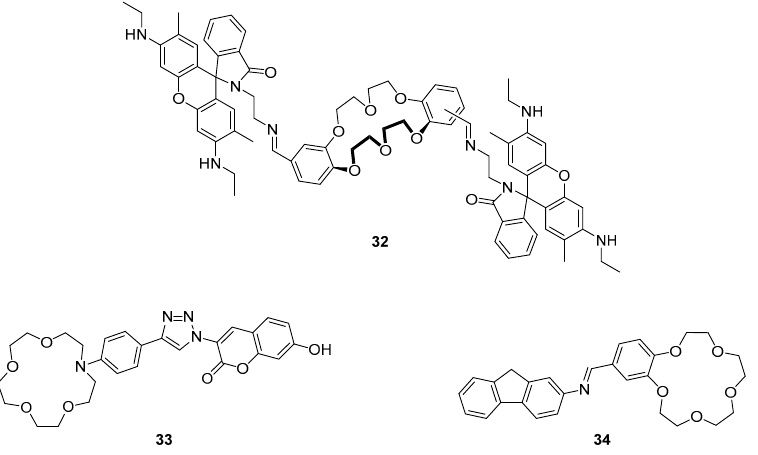
Figure 14. Rhodamine-crown ether conjugate 32 was prepared as a mixture of regioisomers (as indicated), and found to be a selective probe for Cr 3+ ; this substrate elicits a turn-on response from the rhodamine fluorophore that is thought to arise via metal-mediated opening of the spirolactam [109]. Triazolyl-coumarin-aza-crown ether 33 responds strongly to Hg 2+ , Fe 3+ and Cr 3+ , with solvent-dependent variations in response: in water, Fe 3+ triggers a strong enhancement of the fluorescence emission at 475 nm, with weaker responses to Hg 2+ and Cr 3+ , while in ethanol it is Hg 2+ that elicits the strongest response, and smaller responses are seen to Fe 3+ and Cr 3+ [110]. Fluorenyl-imine derivative 34 is a very sensitive and selective probe for Cu 2+ , which triggers a ca. 54-fold fluorescence enhancement thought to arise due to inhibition of both PET and C=N isomerisation quenching processes